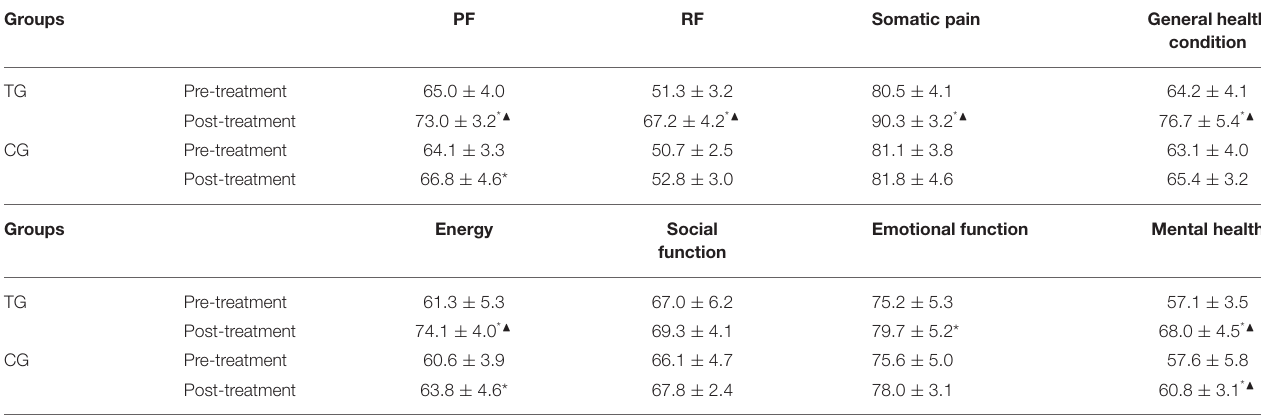
TABLE 3 | Comparison of SF-36 scores between two groups before and after treatment. Groups